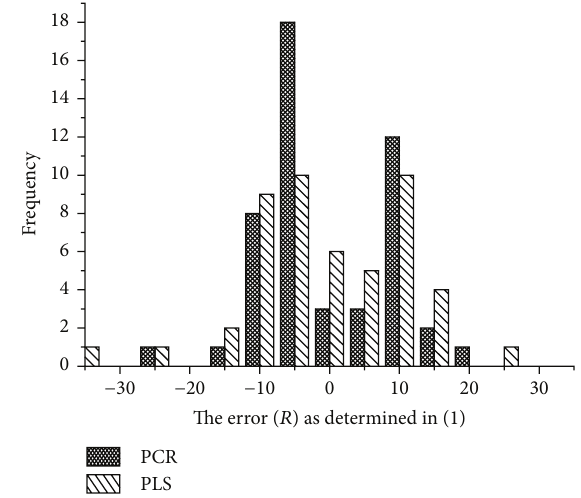
Figure 6: Frequency of 𝑅 from PLS and PCR loadings of wood chemistry